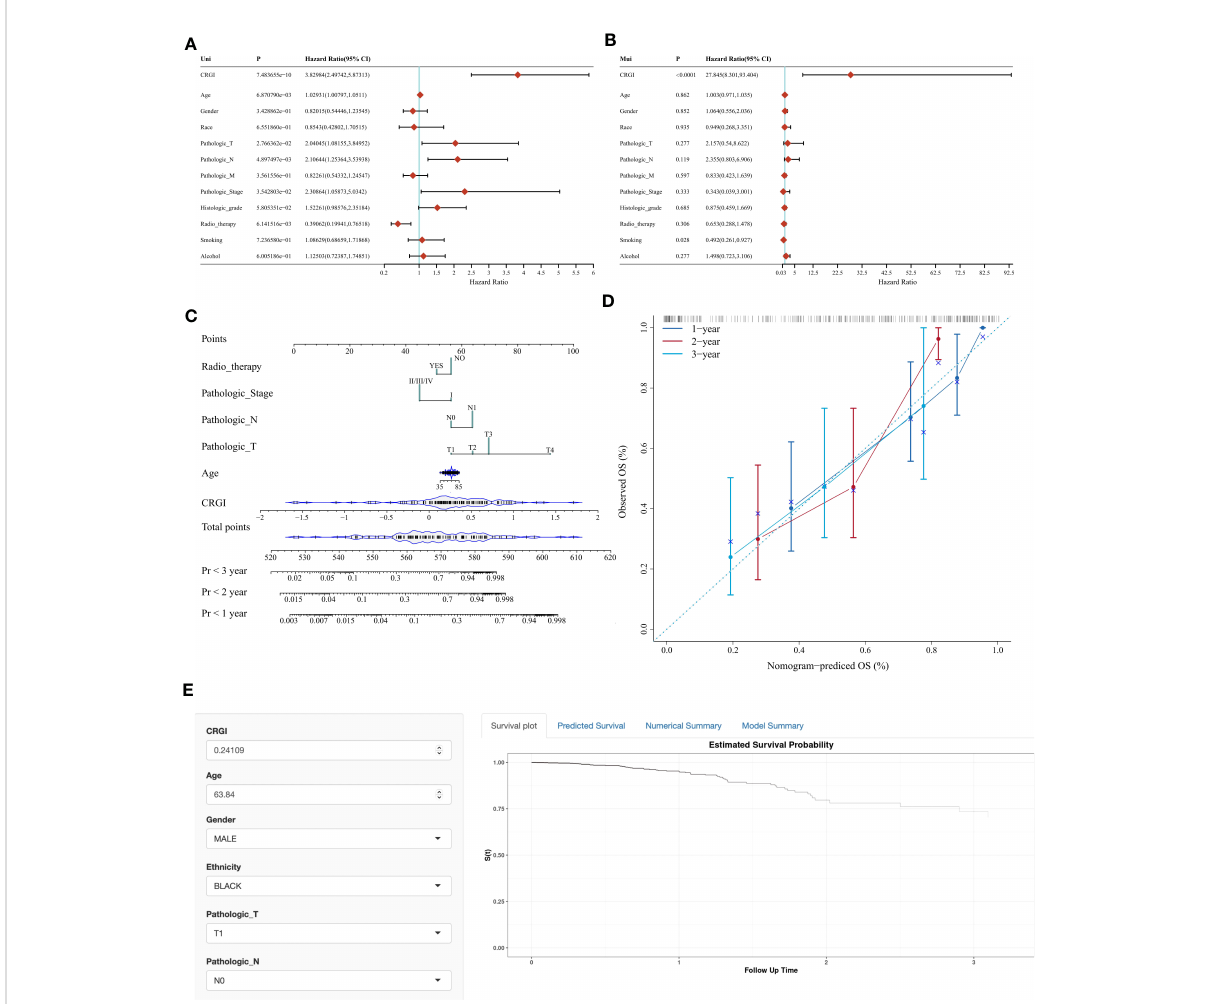
FIGURE 4 Nomogram with clinicopathological characteristics to predict OS in PAAD. (A, B) Forest plots of the results of the univariate and multivariate Cox regression, respectively. (C, D) Conventional nomogram and its calibration curve based on our model. (E) The screenshot of the web-based OS calculator calculating a fi ctional